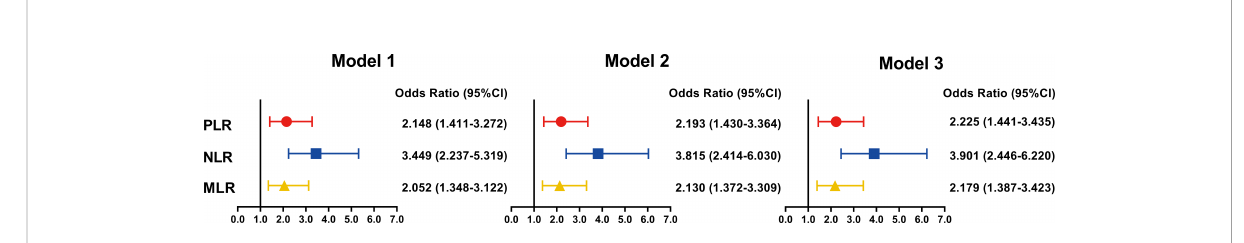
FIGURE 2 Univariate and multivariate logistic regression forest map of adjusted factors and the risk for arterial stiffness.